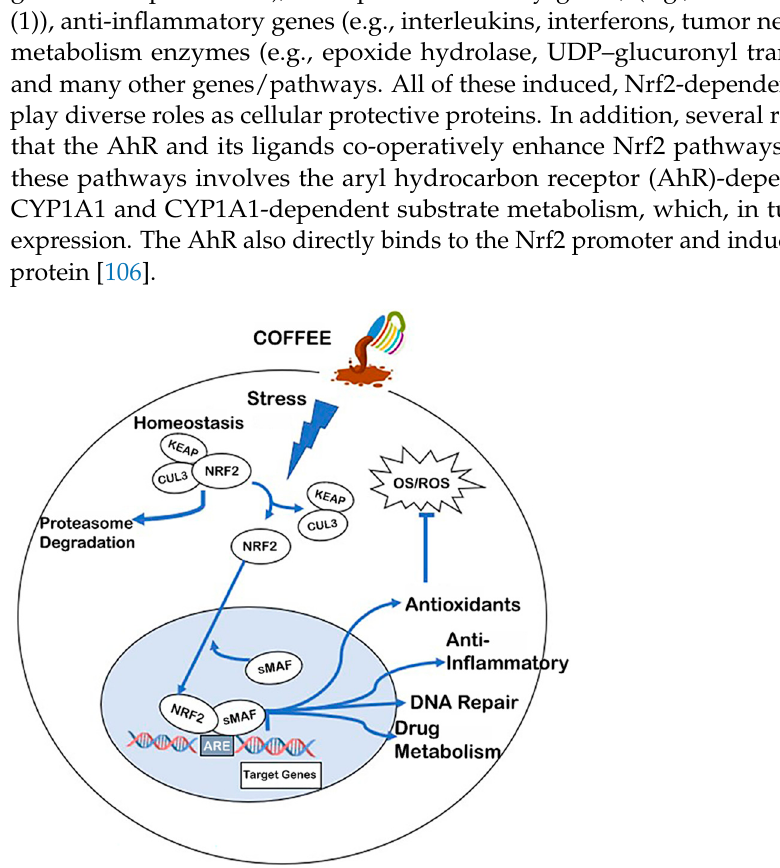
Figure 2. Development of intracellular oxidative stress is attenuated by coffee-induced stress. Coffee-induced stress results in the dissociation of NRF2 from KEAP and the subsequent translocation of NRF2 into the nucleus where the NRF2-sMAF complex binds cis-acting AREs to induce NRF2 regulated genes/pathways, including the antioxidant enzymes glutathione peroxidase (GPx), superoxide dismutase (SOD), quinone oxidoreductase 1 (NQO1), glutathione reductase (GR), harm oxygenase 1 (HO-1), and several thioreductases family members